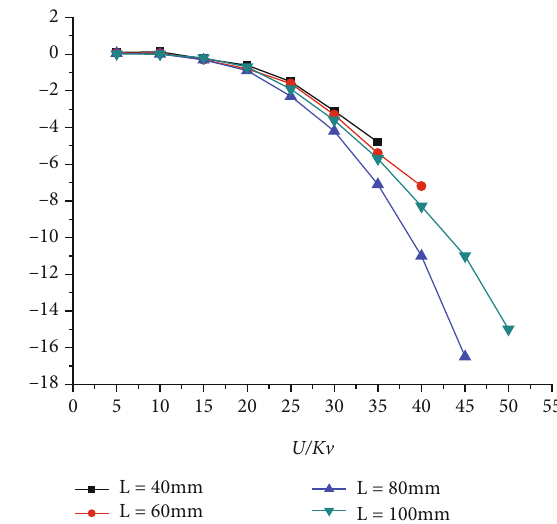
Figure 9: Relationship curve between current of water mist cloud and corona